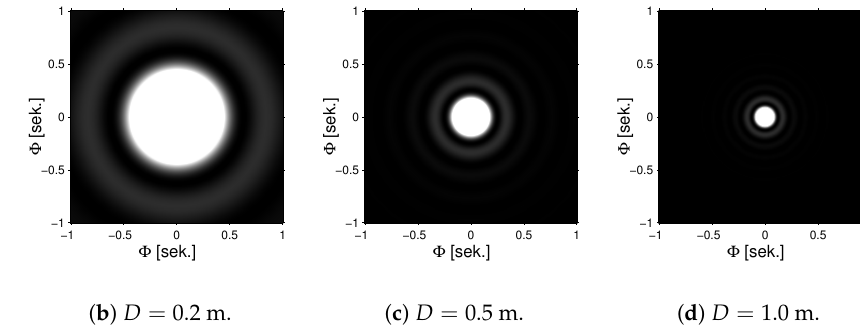
Figure 1. Resolving power of a telescope: ( a ) relationship between resolving power ( C ) and mirror size ( D ); ( b ), ( c ) and ( d ): sample Airy discs for telescopes with mirror sizes of 0.2 m, 0.5 m and 1.0 m,